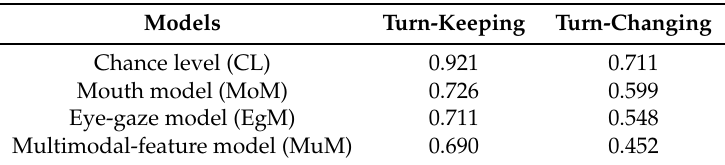
Table 3. Performance of prediction models for predicting utterance interval during turn-keeping and turn-changing. Values are mean absolute errors between actual utterance interval and predicted utterance interval by prediction